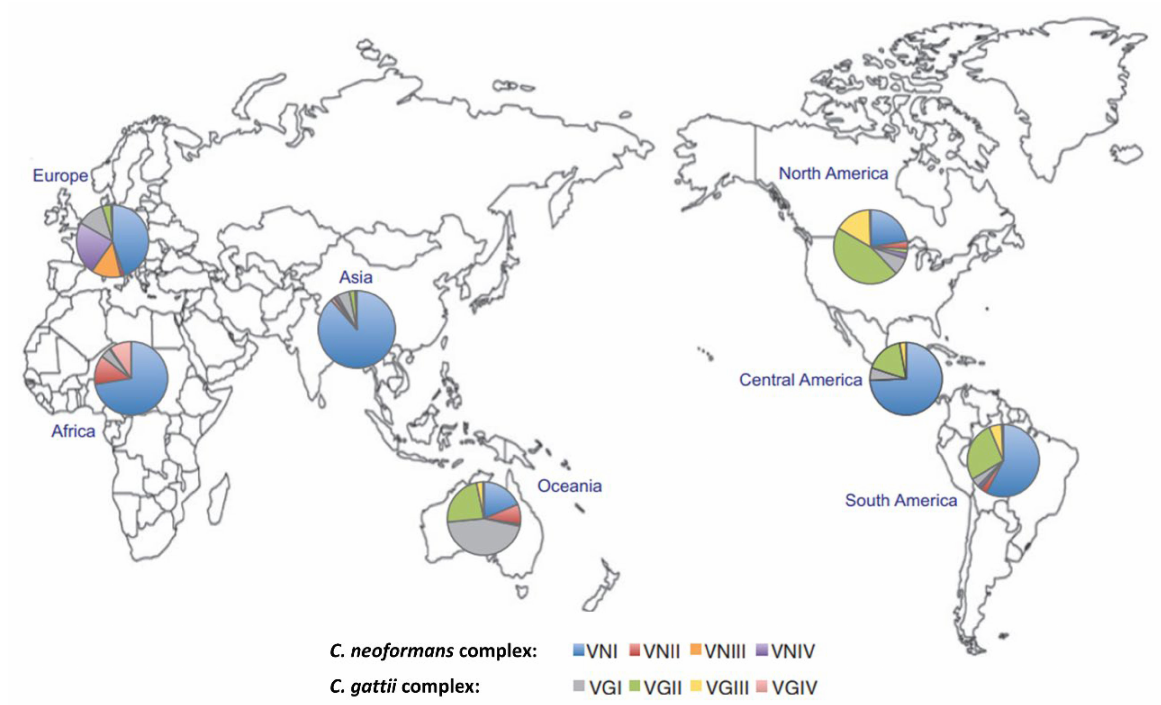
Figure 1. Geographical distribution of the major molecular types within the Cryptococcus neoformans and Cryptococcus gattii species complexes. Authors’ adaptation from